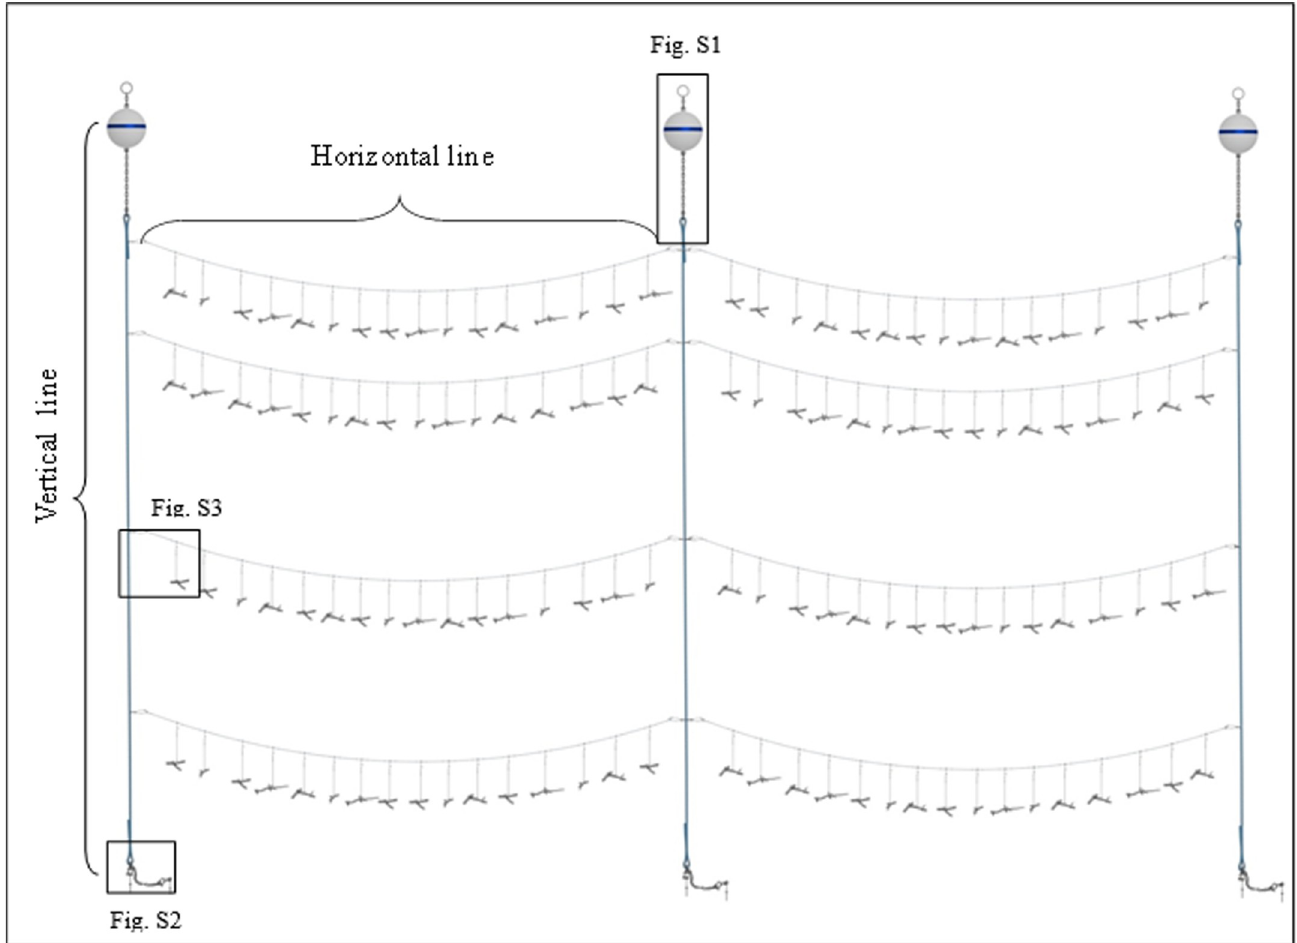
Fig 2. Diagram of line nursery built using three vertical lines and eight horizontal lines. Each nursery supports 128 coral individuals with a footprint of approximately 8.2 meters tall and 14 meters wide. freely and reduce entanglement. The total height of the vertical line, including all the con- necting hardware, was approximately 8.2 m. The buoy remained 2–3 m below the water sur- face to minimize wave action and to prevent boat strikes (S1 Fig). Each vertical line was anchored 7 m apart into the hard bottom. A secondary anchor was placed about 0.6 m from the original anchor in case of detachment and as an extra precaution for each vertical line (S2 Fig). Horizontal lines ran parallel to one another and were spaced along the vertical line at depths of approximately 6 m, 7.5 m, 9 m, and 10.5 m from the surface. The horizontal lines were secured by looping nylon and polypropylene mix line to the vertical lines. Stainless steel long- line clips, with the swivel attachment removed, connected the nylon and polypropylene mix loop to the 7 m long horizontal lines (S3 Fig). Each of the eight horizontal lines supported 16 coral pieces spaced approximately 30 cm apart to allow for growth and prevent entanglement. The corals were suspended onto the horizontal lines using a stainless steel longline clip to allow movement in currents. Double barrel crimps were placed on either side of each coral to prevent sliding along the horizontal line (S3 Fig).